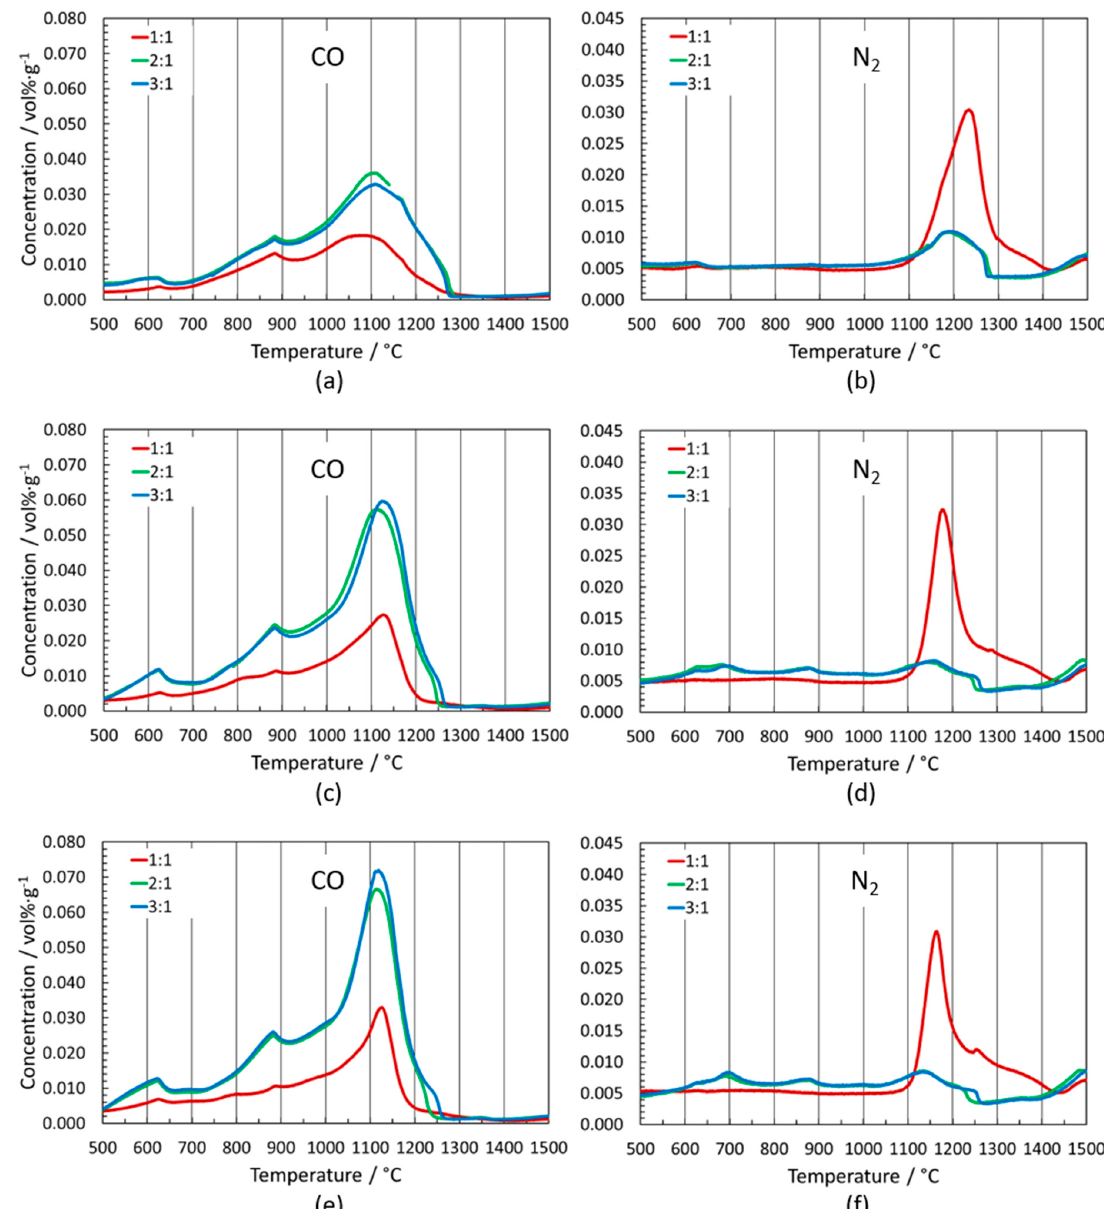
Figure 5. Left, ( a ), ( c ), ( e ): CO and right, ( b ), ( d ), ( f ): N 2 outgassing of cermet powder mixtures